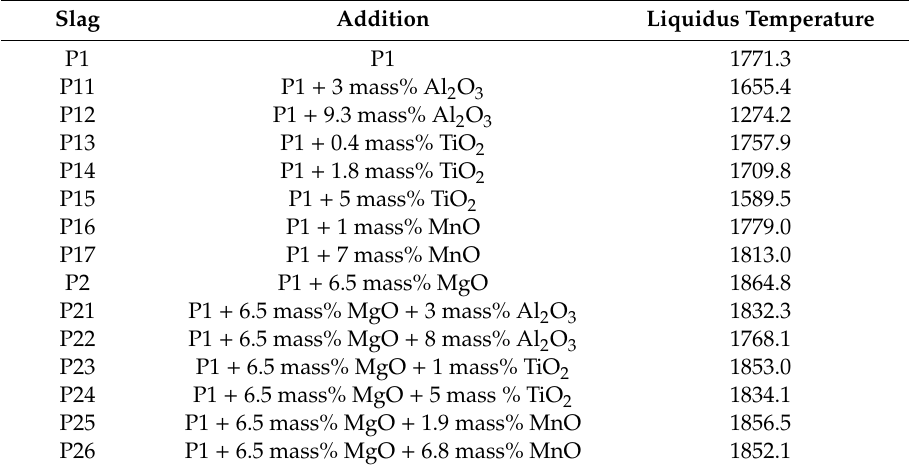
Table 2. Investigated basic oxygen furnace (BOF) slag and calculated liquidus temperature [ ◦